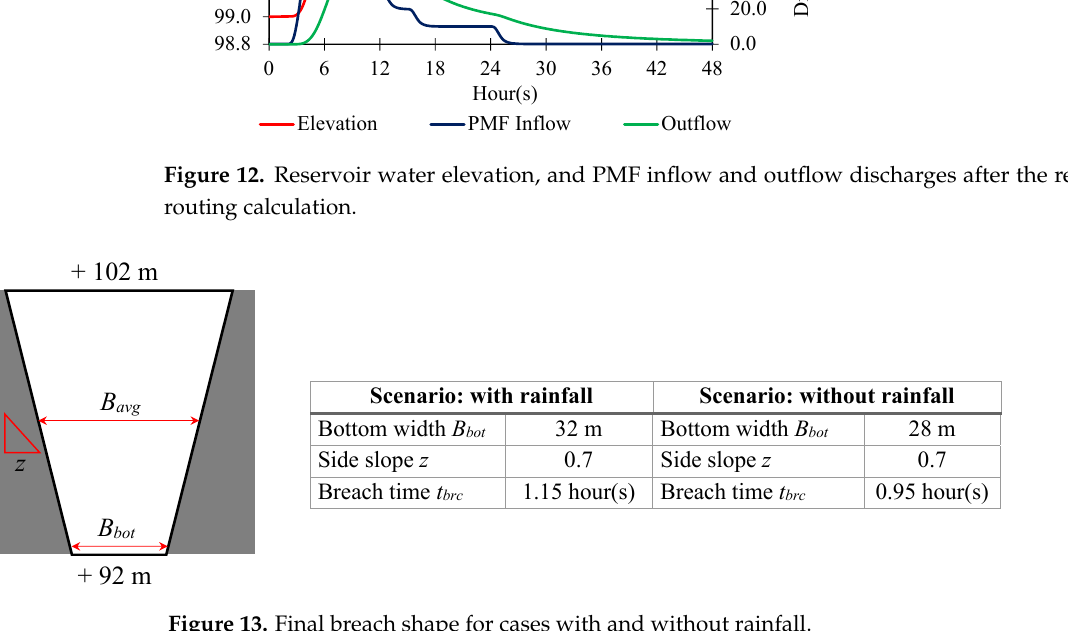
Figure 13. Final breach shape for cases with and without